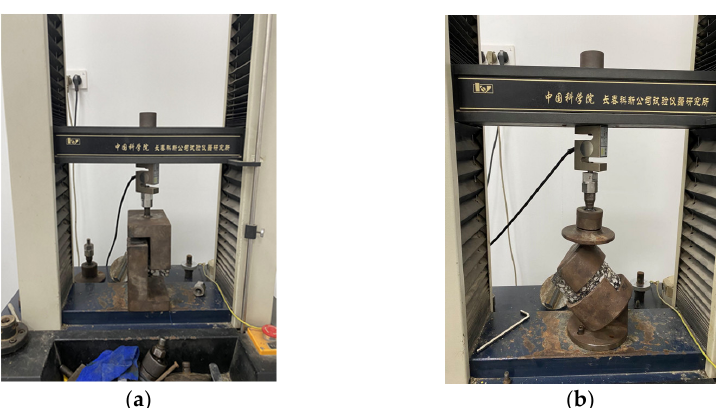
Figure 3. The direct shear and oblique shear apparatus: ( a ) the direct shear apparatus; ( b ) the oblique shear apparatus (Chinese in the figure: Changchun Kexin Company Test Instrument Research Institute, Chinese Academy of